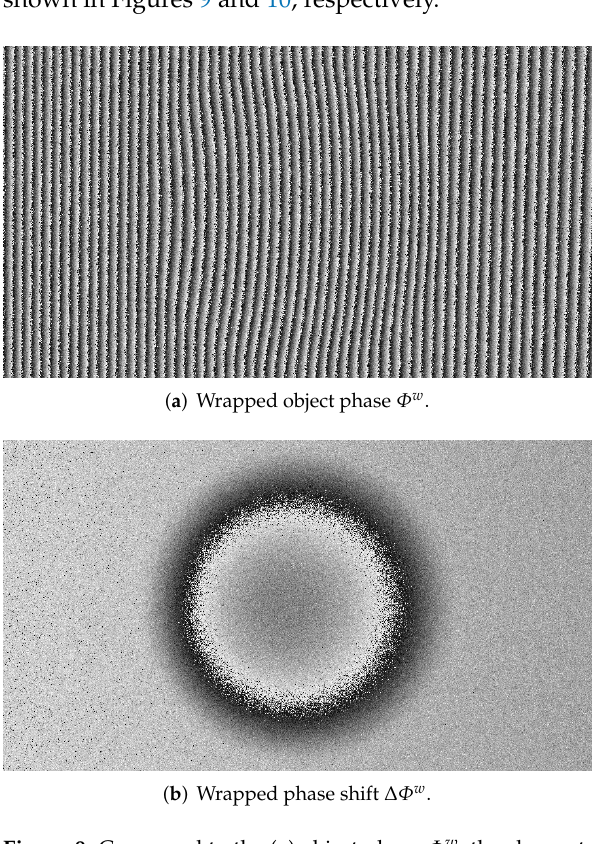
Figure 9. Compared to the ( a ) object phase Φ w , the slower trend of the ( b ) phase shift ∆ Φ w is clearly visible in a simulated dent with added white noise ( σ =